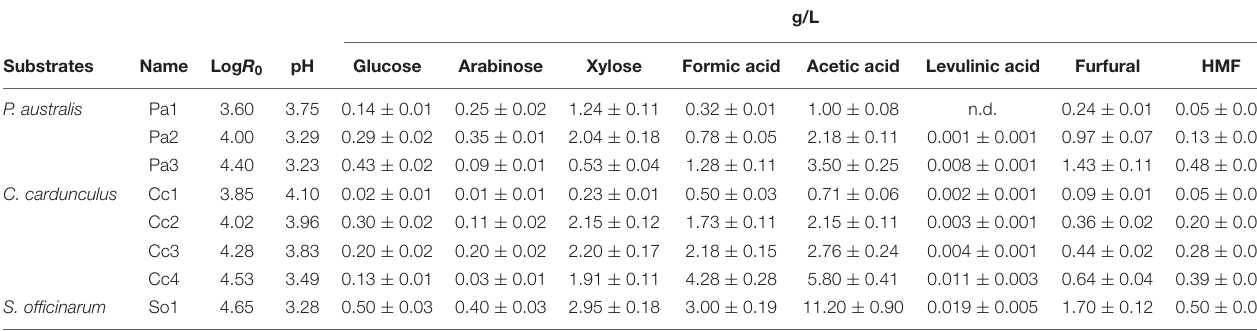
TABLE 1 | Pre-treatment parameters, pH, and composition of the pre-hydrolysates used in this study.